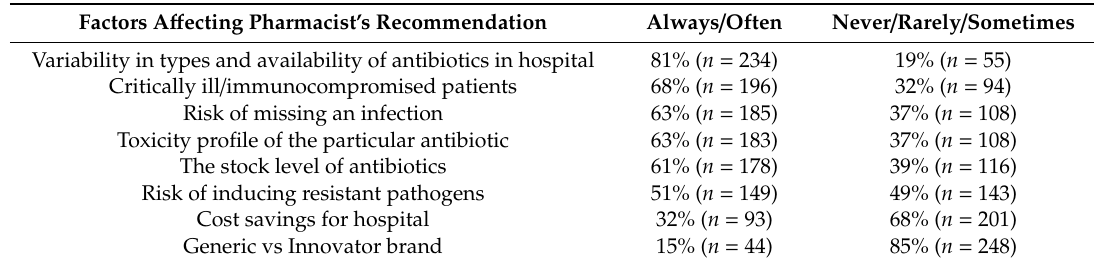
Table 6. A ff ecting the pharmacist’s recommendation of antibiotic